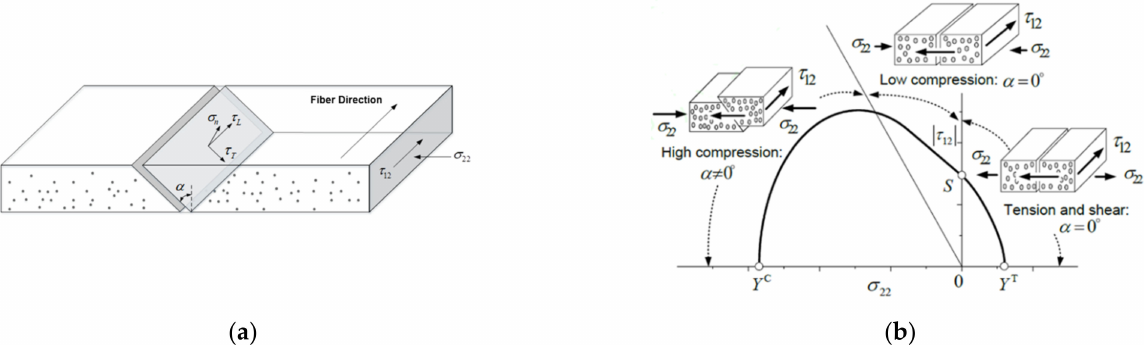
Figure 15. ( a ) The angle between the fracture surface and the through thickness direction and ( b ) the change in the fracture angle α under different stress conditions.